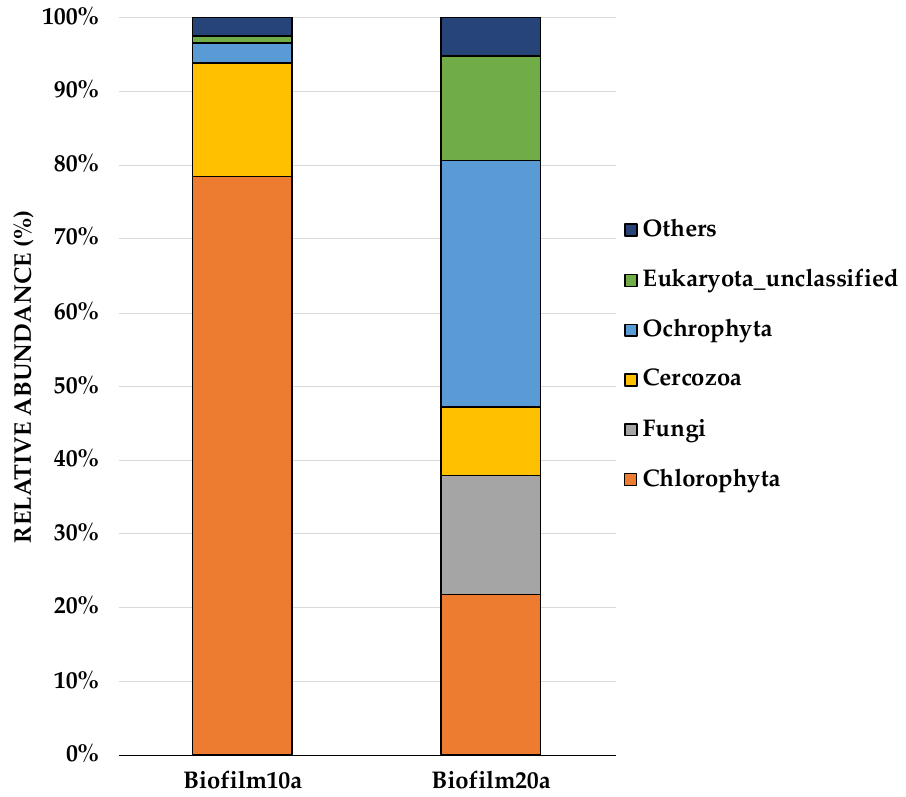
Figure 3. Stacking bars illustrating the relative abundances of Eukaryota at the phylum level in Biofilm10a and Biofilm20a, revealed by 18S sequencing. Microbial phyla that composed less than 1% of the dataset were grouped under the ‘Other’ category. Biofilm10 corresponds to 10-week-old biofilms; Biofilm20 corresponds to 20-week-old biofilms. Biofilm10a and Biofilm20a refer to biofilm samples taken from the top layer of the biofilms.